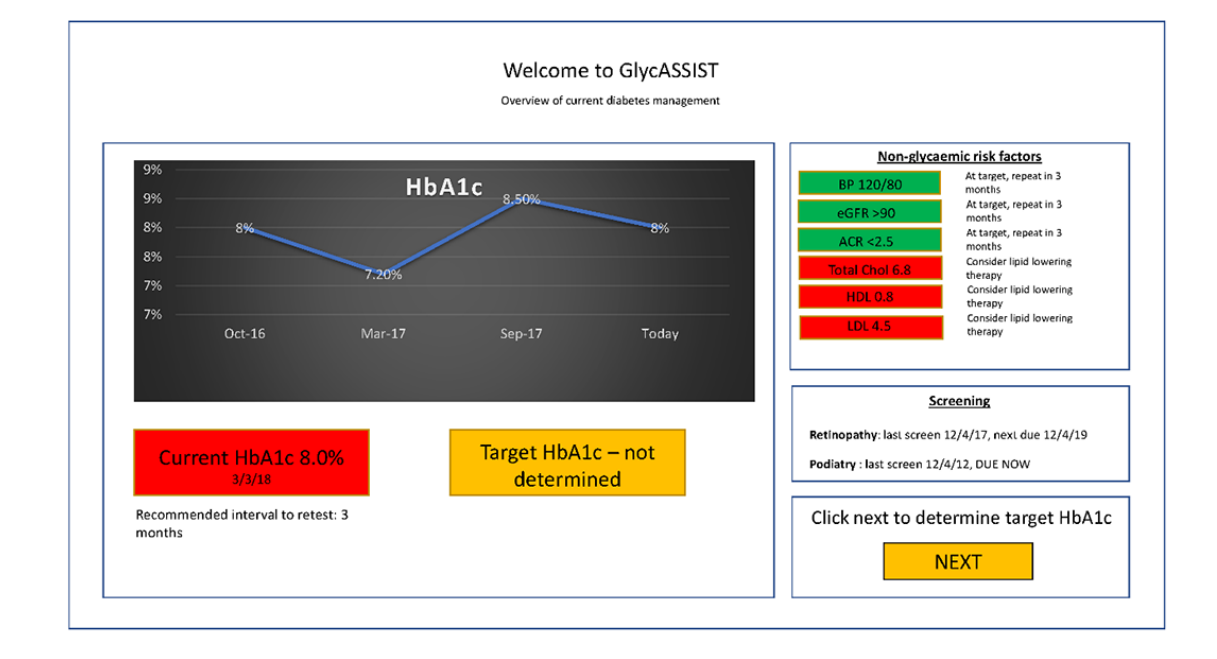
Figure 1. Initial prototype—page 1. ACR: albumin/creatinine ratio; BP: blood pressure; eGFR: estimated glomerular filtration rate; HbA1c: